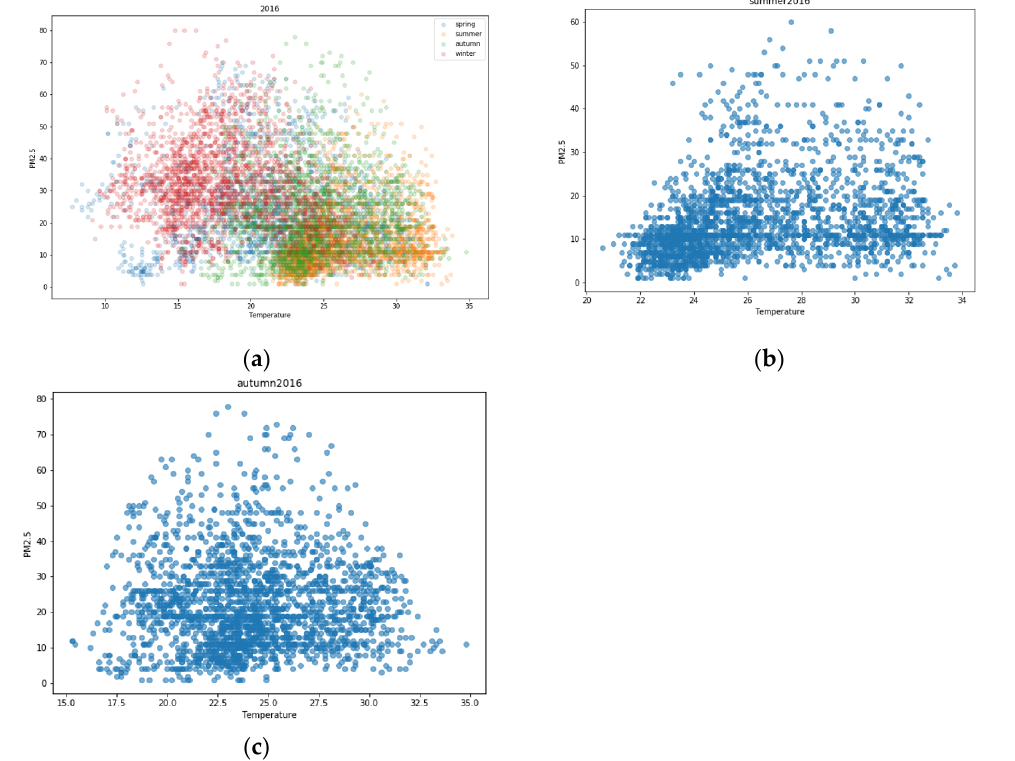
Figure 2. Relationship between temperature and PM 2.5 concentrations observed at Puli EPA supersite. ( a ) Entire year 2016 with a different color for each season; ( b ) summer; ( c ) autumn.